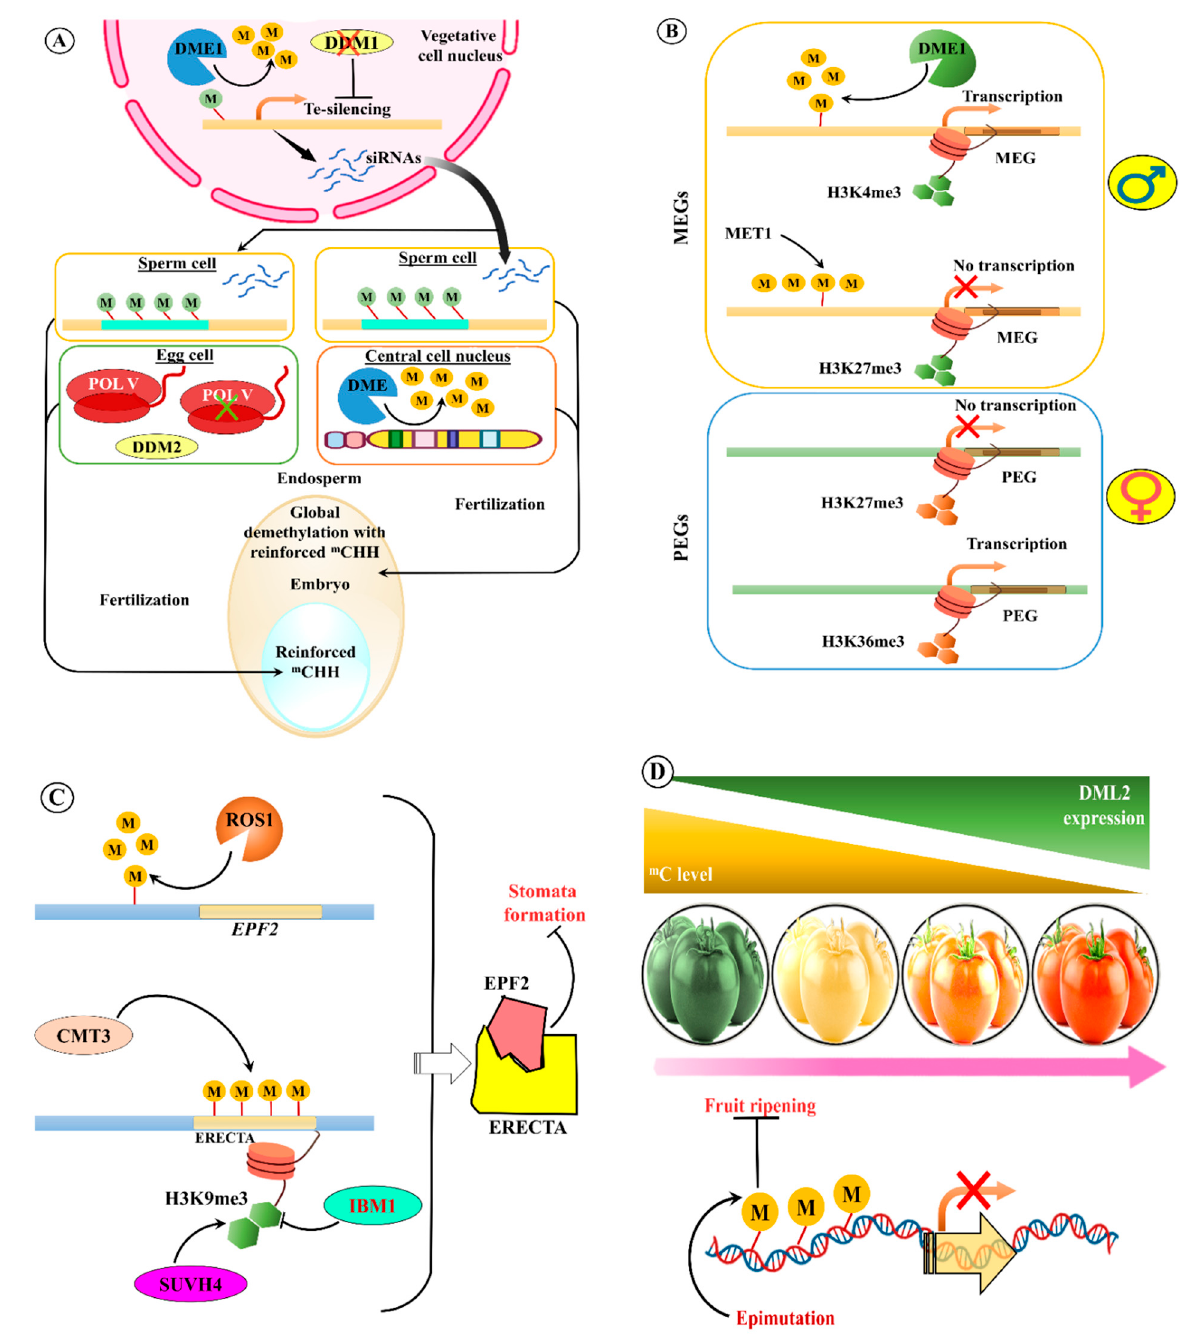
Figure 3. Functions of transposable element (TE) methylation in plant growth, stomata formation, and fruit ripening. ( A ) In the vegetative cell (male gamete) of Arabidopsis , the TE is silenced by DME-mediated DNA methylation by downregu- lating the chromatin remodeller DDM1. Small interfering RNAs (siRNAs) derived from TE transcripts travel from the